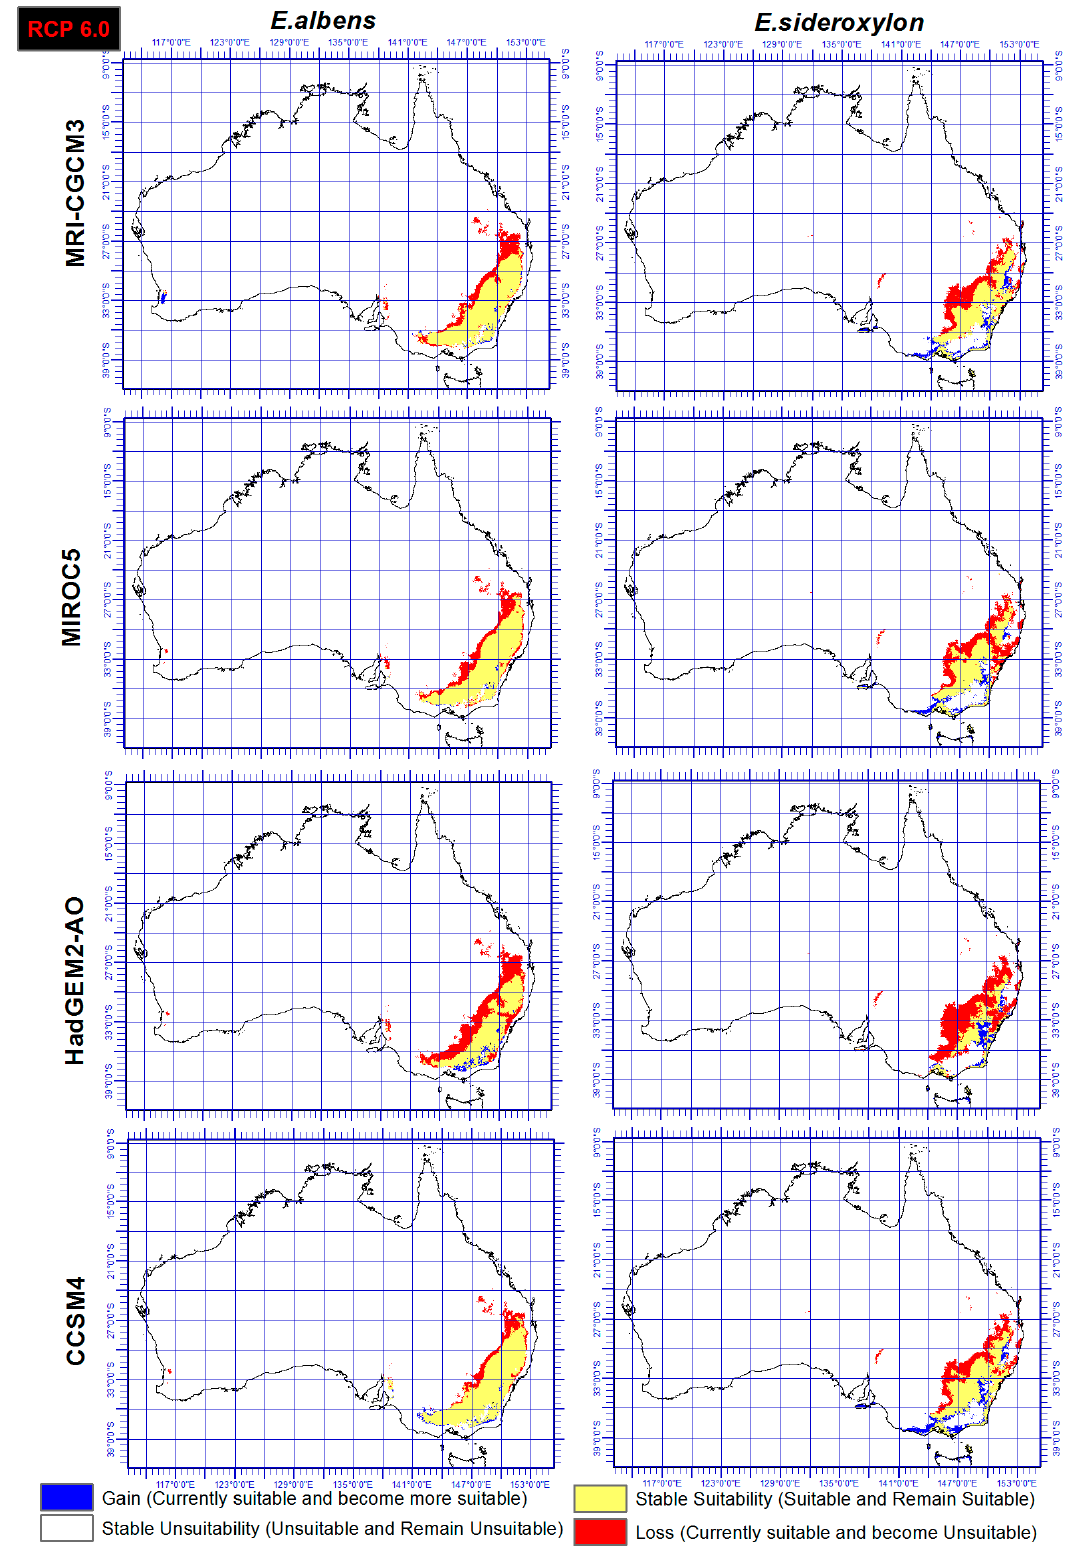
Figure 5. Ensemble output of four SDMs, under RCP 6.0 and four GCMs indicating range gain, loss or as is of Eucalyptus sideroxylon and E. albens by 2050.